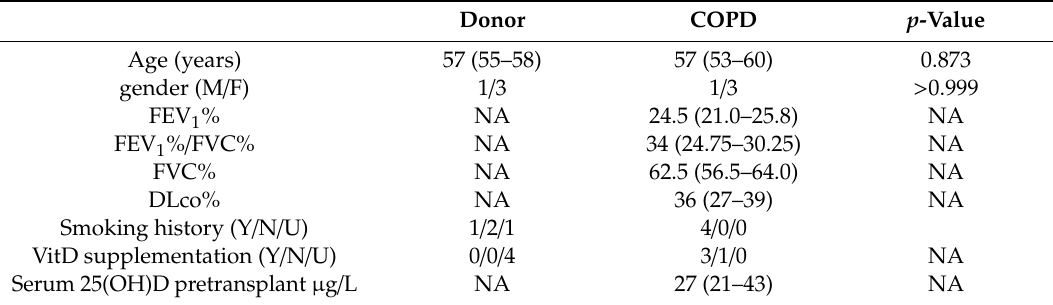
Table 2. Patient characteristics.